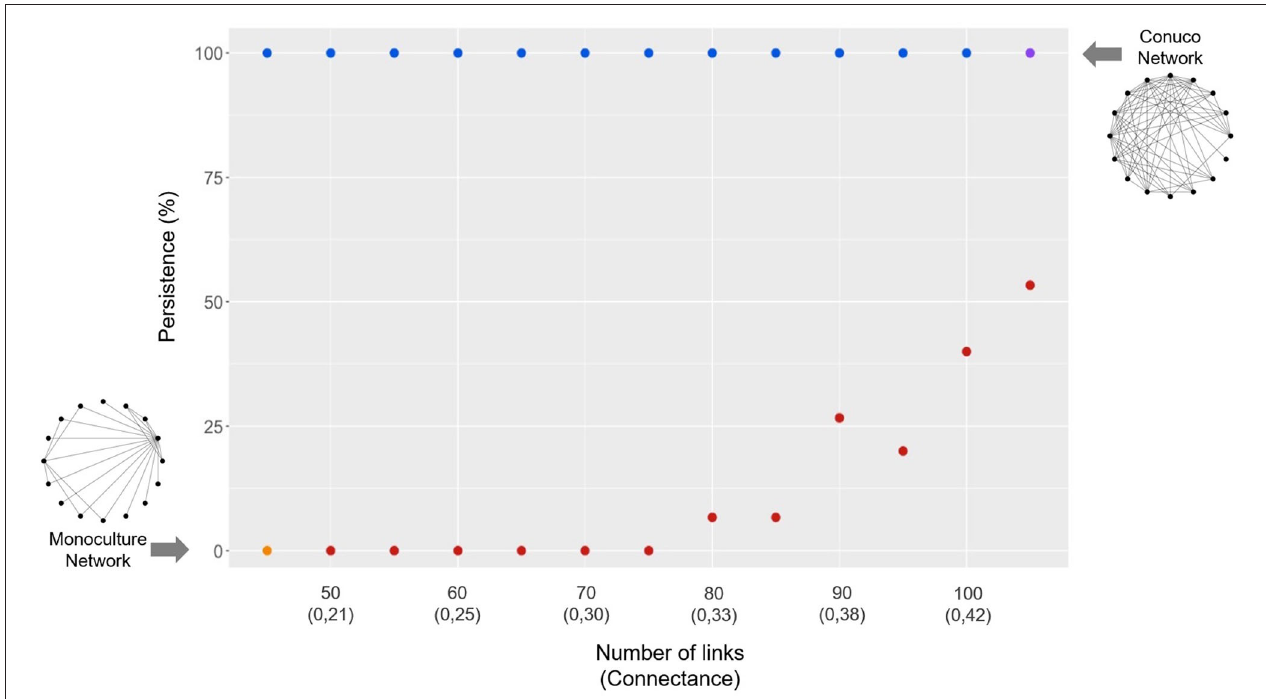
FIGURE 5 | Relationship between percentage of persistence of final networks and number of links of initial networks (corresponding connectance value below), for the link up path (red dots) and link down path (blue dots). Original networks also shown, Monoculture (orange dot) and Conuco (purple dot). Arrows show the direction of the process for each path (see text and Figure 4